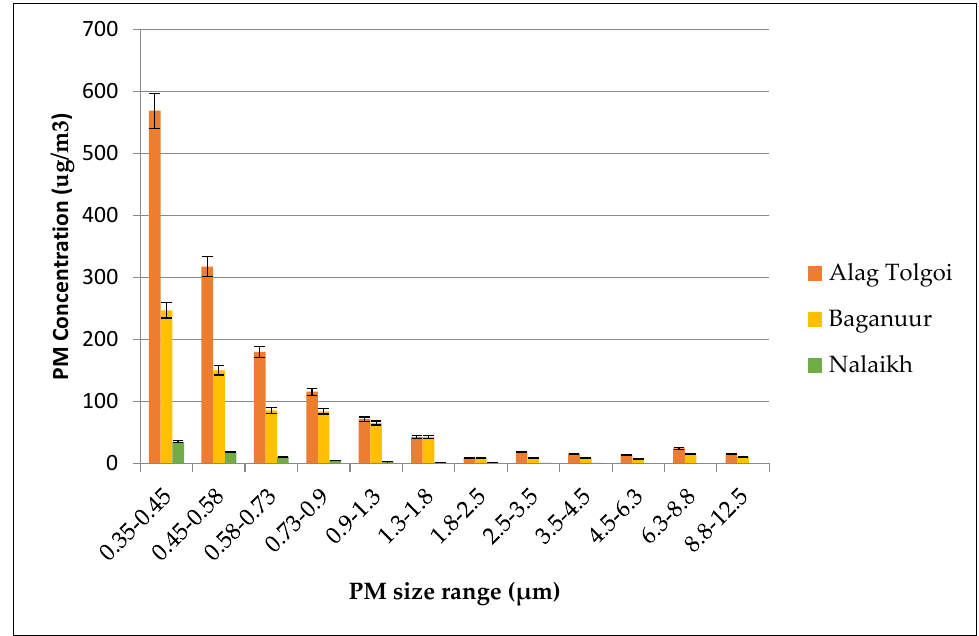
Figure 2. Size distribution of particulate matter (PM) from different types of coal.